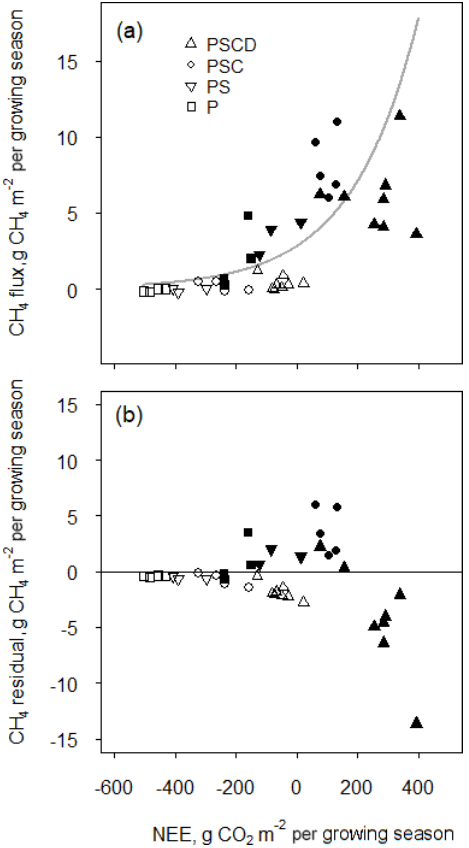
Figure 4. (a) The relationship between the net ecosystem CO 2 uptake (NEE) and CH 4 flux during the growing season of 2004 described with an exponential model and (b) the residuals of the model, in the different plant removal treatments at wet (solid sym- bols) and water level drawdown (open symbols) subsites. Vegeta- tion treatments: PSCD – plots with intact vegetation, consisting of peat, Sphagnum mosses, sedges, and shrubs; PSC – plots consist- ing of peat, Sphagnum mosses, and sedges (shrubs removed); PS – plots consisting of peat and Sphagnum mosses (shrubs and sedges removed); P – plots consisting of bare peat (all vegetation removed). NEE is positive when the fen is a net sink of atmospheric CO 2 . Methane flux is positive when the fen is a source of CH 4 to the